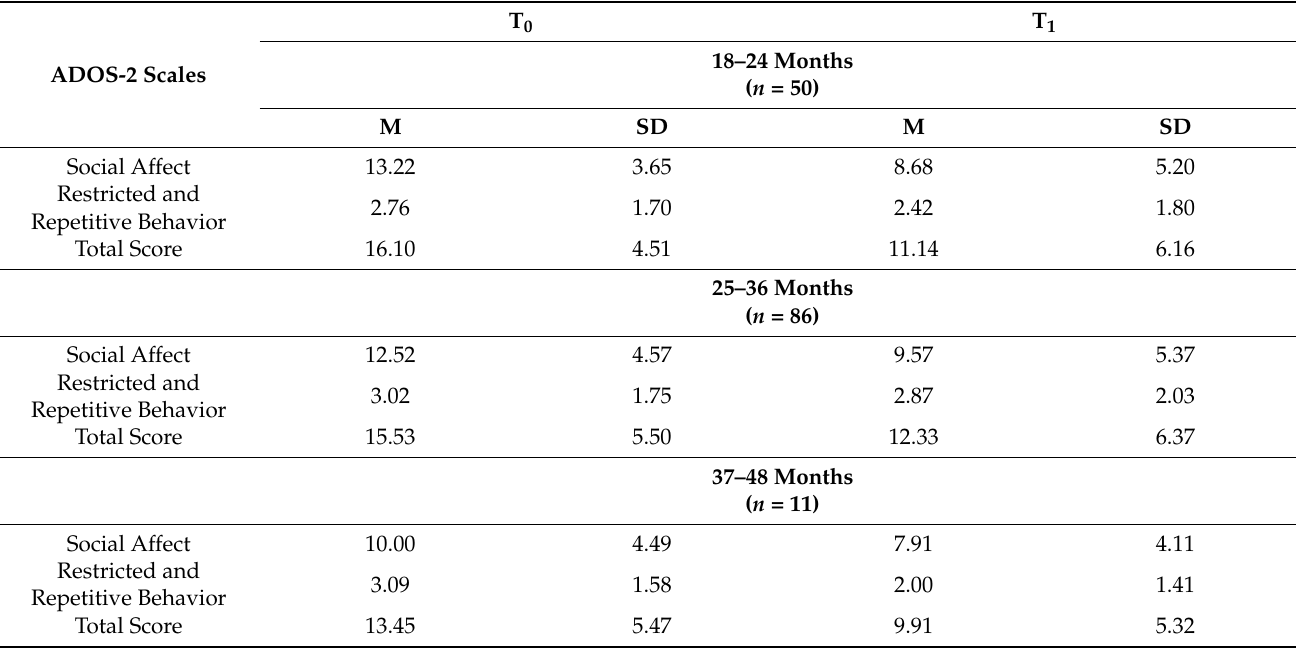
Table 6. T 0 and T 1 descriptive statistics of ADOS-2 sub-scales and total score as a function of the three age classes